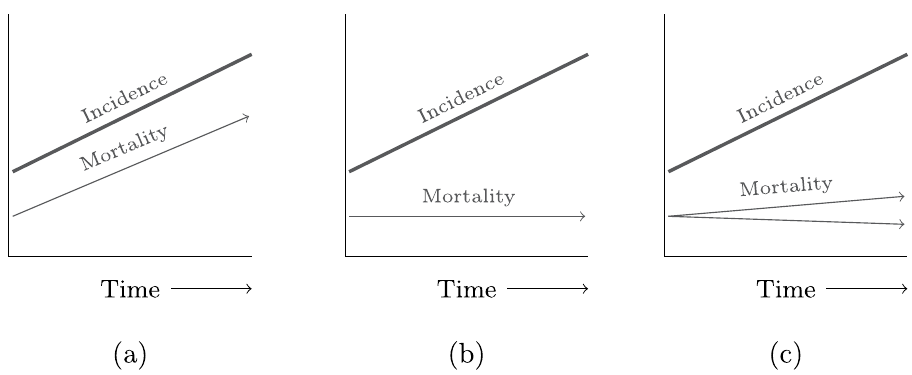
Figure 2. Trends in incidence and mortality for ( a ) a true increase in disease and ( b ) a disease being overdiagnosed and ( c ) overdiagnosis predominates but changes in underlying disease